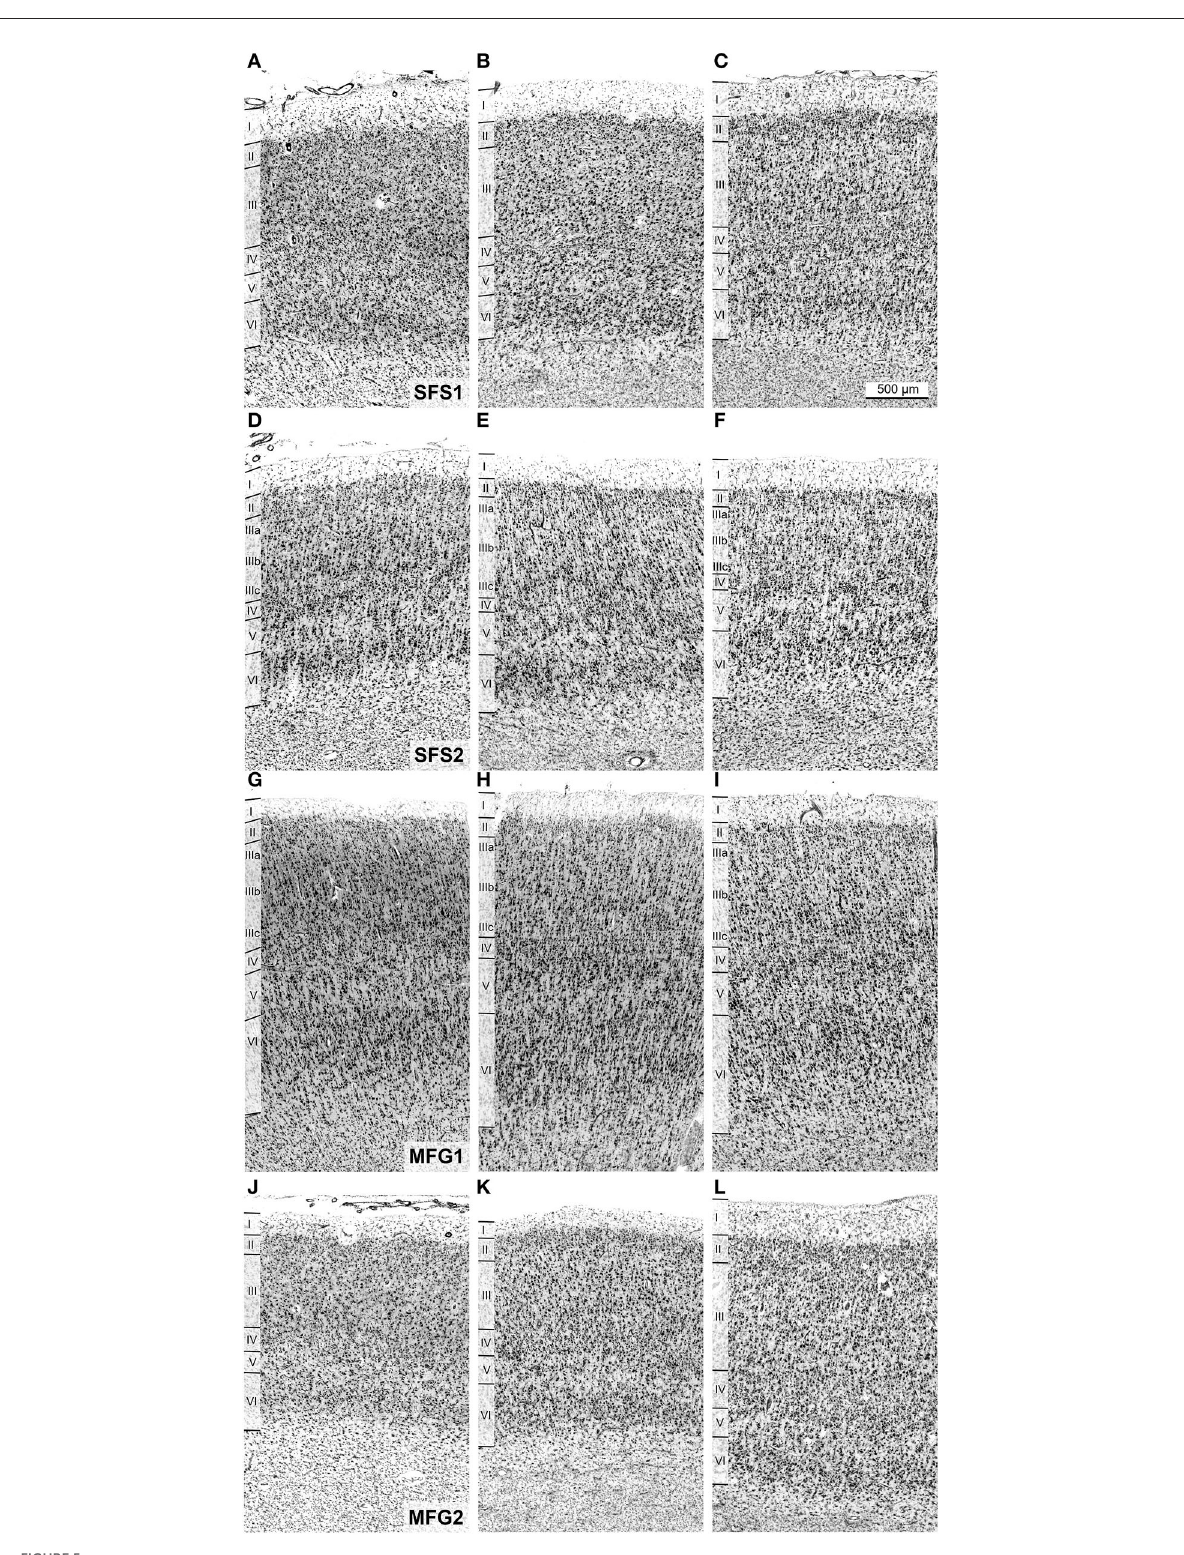
FIGURE5 Cytoarchitecture and interindividual variability of anterior dorsolateral prefrontal cortex areas. Areas SFS1 (A–C) , SFS2 (D–F) , MFG1 (G–I) , and MFG2 (J–L) of three individual post-mortem brains are shown. Despite the intersubject variance between the individual brains, the decisivecytoarchitectoniccharacteristicscanberecognized.Forexample,areaSFS1wascharacterizedbyahighcelldensityoflayerIIanddistinct